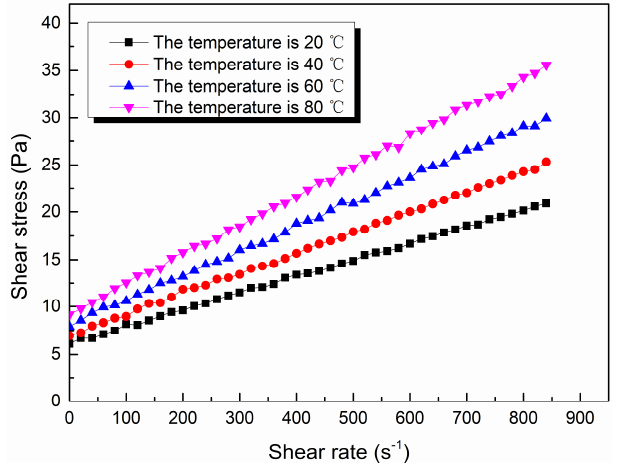
Figure 13. The rheological curve of the ordinary cement slurry at different temperatures.